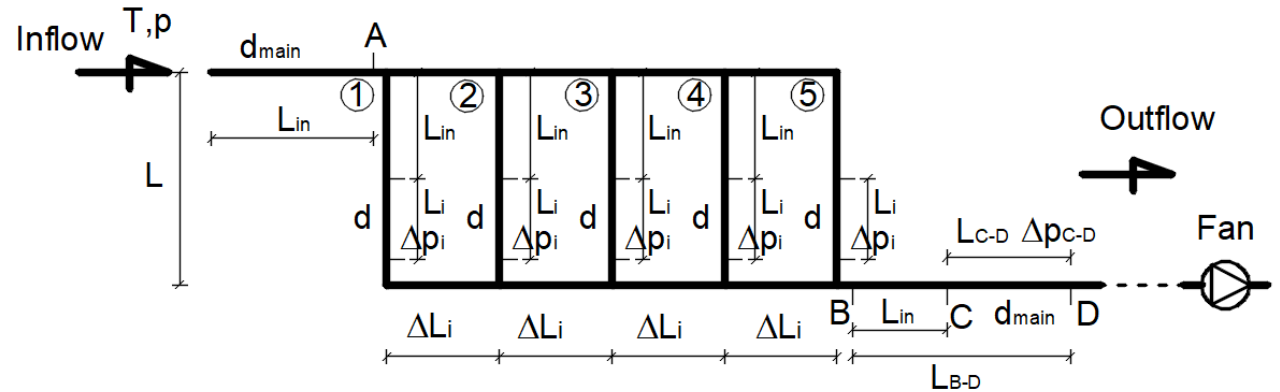
Figure 2. Schema of the experimental setup: d main —internal diameter of a manifold (PP DN50 = 0.0461 m), L in —flow developing sector of a length at least >30 d , d —internal diameter of each branch-pipe (PP DN50), ∆ p i —pressure drop at the measuring sector of i branch, ∆ L —distance between parallel pipes = 6 d , previously presented in the authors’ work [48].